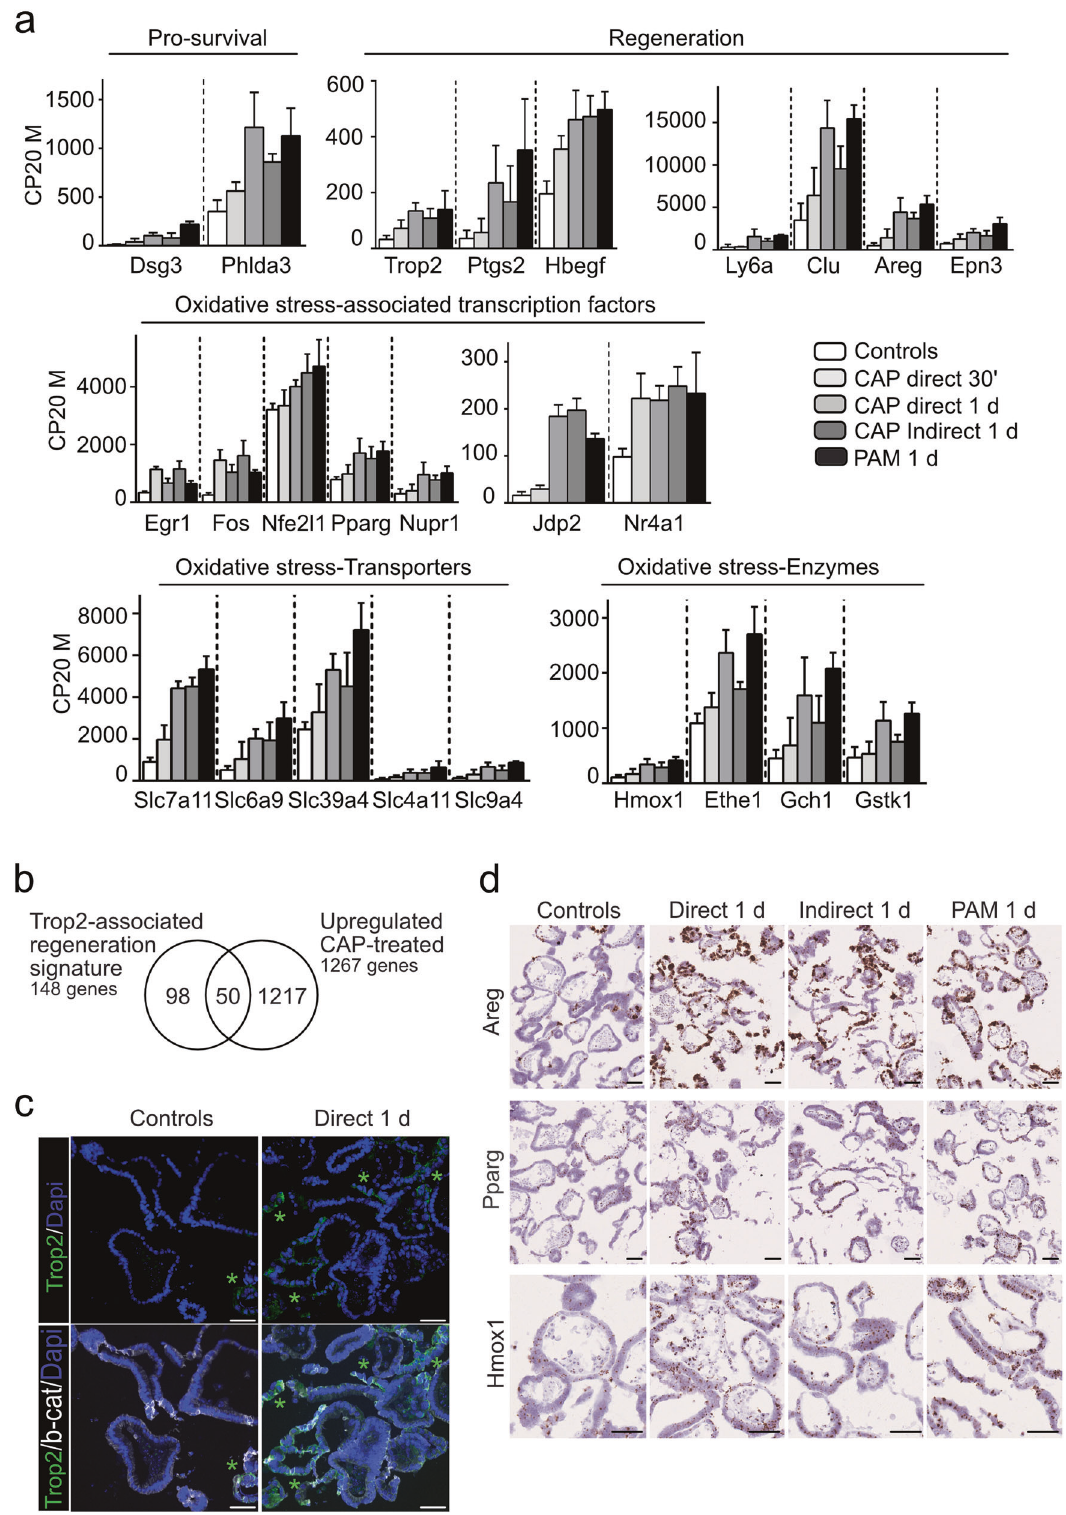
Fig. 5 CAP treatment induces a global response to reactive species in intestinal stem cell-derived organoids. a Expression levels of Pro- survival, regeneration and oxidative stress-associated genes in the various conditions reported in CP20M. Data are represented as means ± sd. n = 4 and 3 samples in controls and CAP-treated conditions, respectively. b Venn diagram showing that part of the upregulated gene list in CAP-treated vs control organoids (50 out of 1267 genes) corresponds to the Trop-2-associated regeneration signature. c Immuno fl uorescence showing Trop2-expressing cells (visualized by green asterisks) in organoids at day 3. Cell membranes were shown with β -catenin and nuclei counterstained with DAPI. d Expression of Areg , Pparg , and Hmox1 genes detected in organoids by RNAscope at day 3. Scale bars: 50 µm ( c , d ).